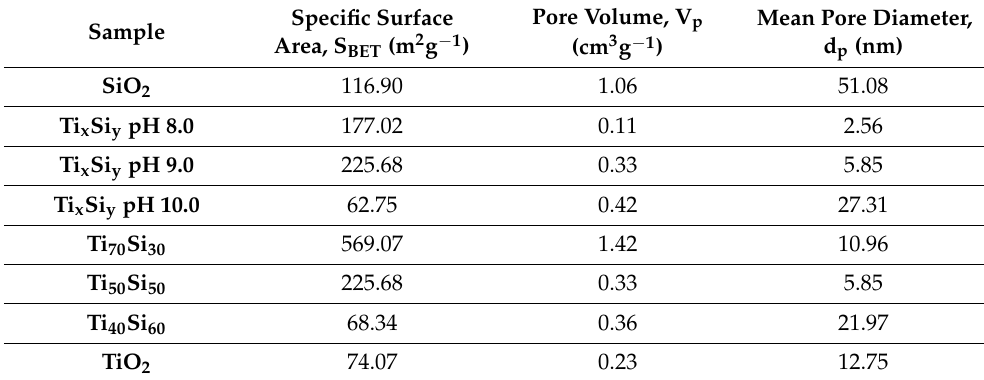
Table 6. Specific surface area, pore volume, and mean pore size of TiO 2 , SiO 2 , and Ti 50 Si 50 oxide synthesized at various pH values, and Ti x Si y oxide synthesized at pH 9.0 with different Ti/Si